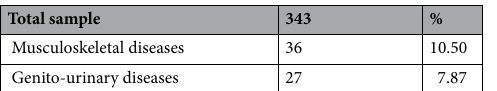
Table 1. Sociodemographic characteristics and admission motive of participants.